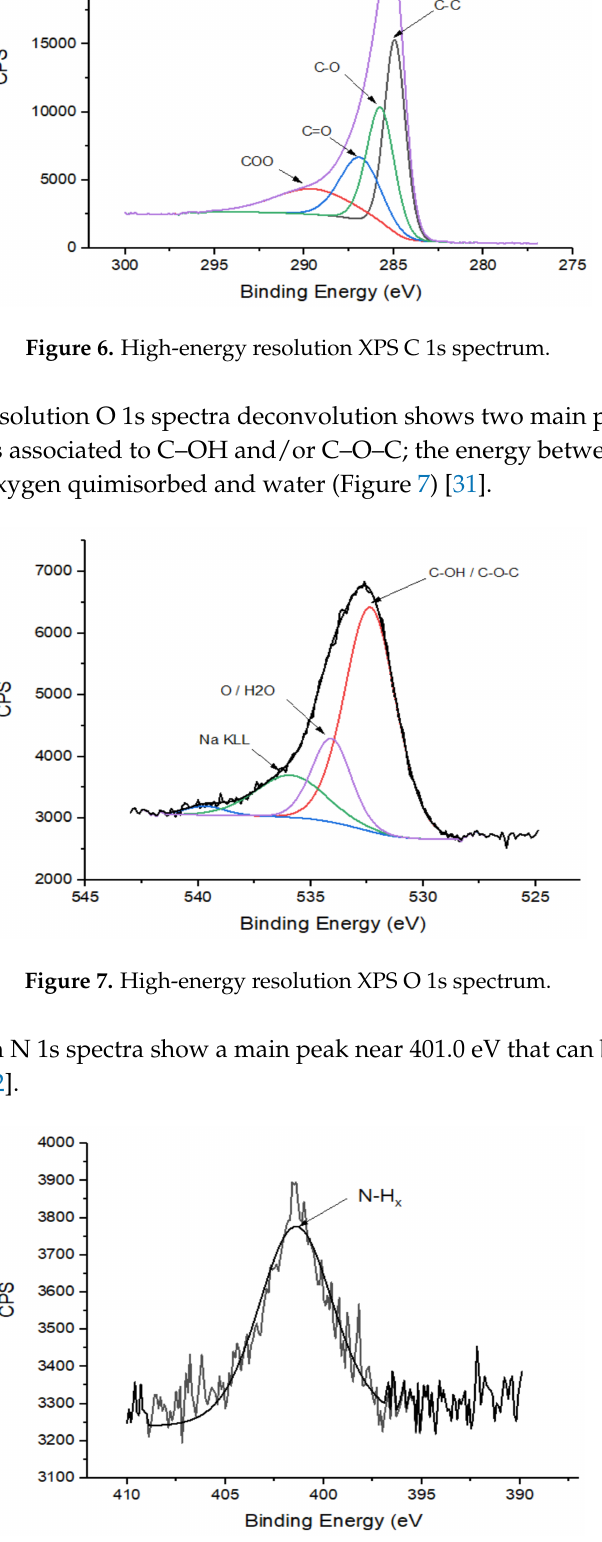
Figure 8. High-energy resolution XPS N 1s